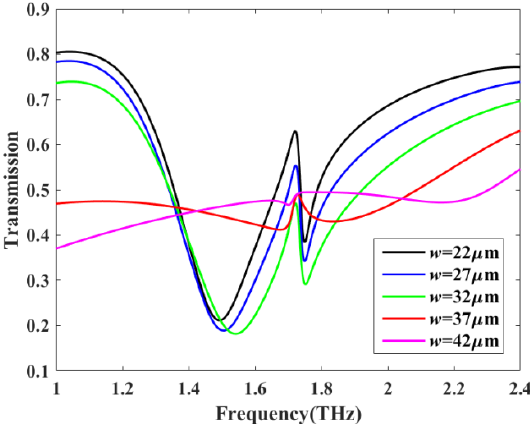
Figure 7. Transmission spectra of metamaterial with different widths of the graphene strip.